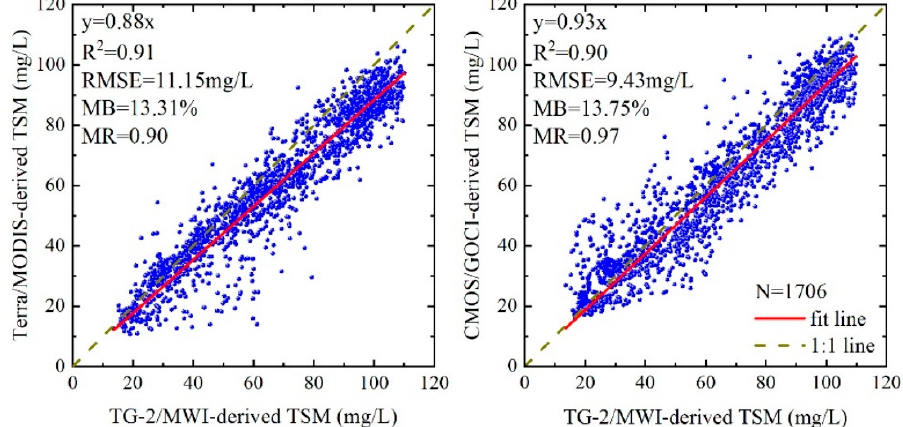
Figure 13. Statistical analysis of TG-2/MWI-derived TSM, Terra/MODIS-derived TSM and CMOS/GOCI-derived TSM products.